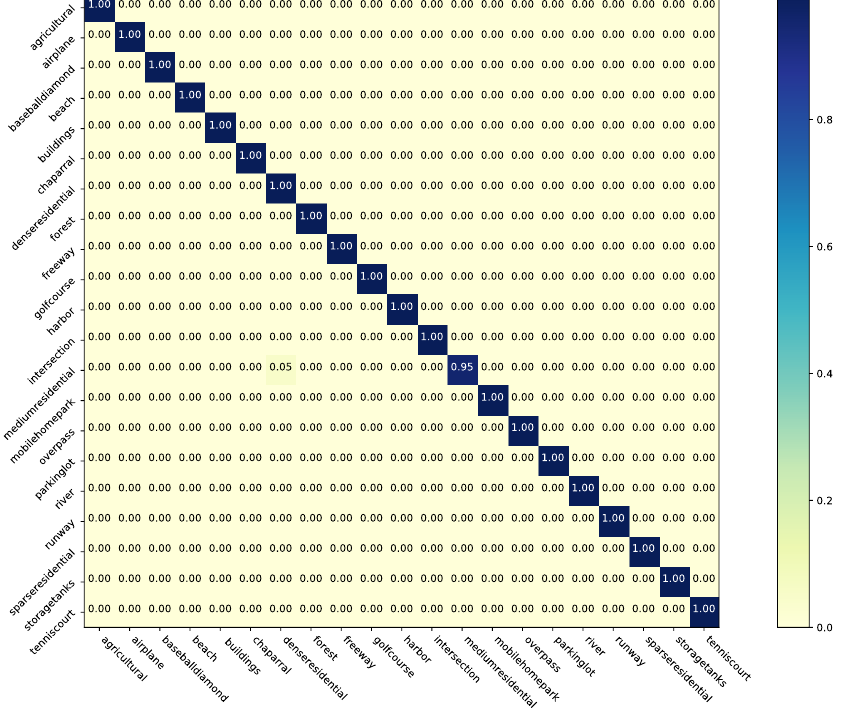
Figure 8. The confusion matrix of NLD with full UC Merced Land-use